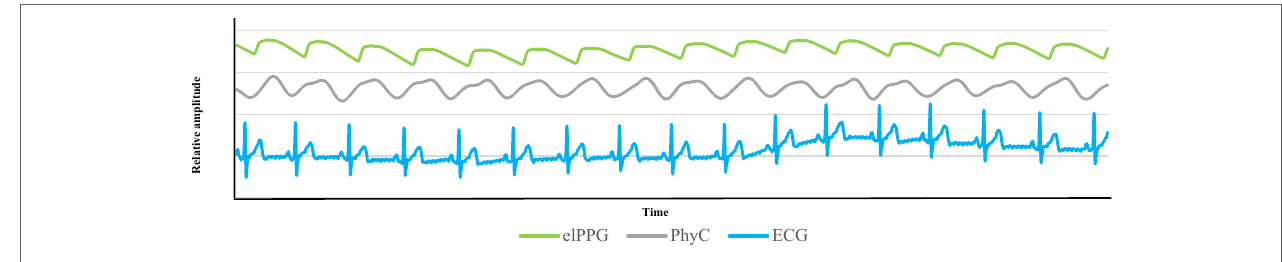
FigUre 2 | Physiological signals. Plot of 15 s of data for participant #01 during 1BSL, the green line represents the elPPG, the gray line is the PhysioCam (PhyC), and the blue line is the electrocardiogram